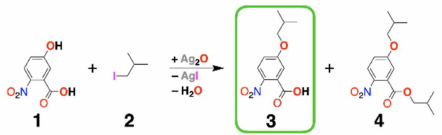
Figure 3. Purdie-Irvine alkylation (PIA) leading to an ether 2-nitrobenzoic acid (NBA) precursor (in the green frame) for the synthesis of Aa bioinspired molecular electrets (Figure 1; Figure 2b). The exact masses of the products, obtained using as high-resolution mass spectrometry (HRMS), along with their 1 H and 13 C nuclear magnetic resonance (NMR) spectra (Figure S1 and S2), confirm the identities of 3 and 4